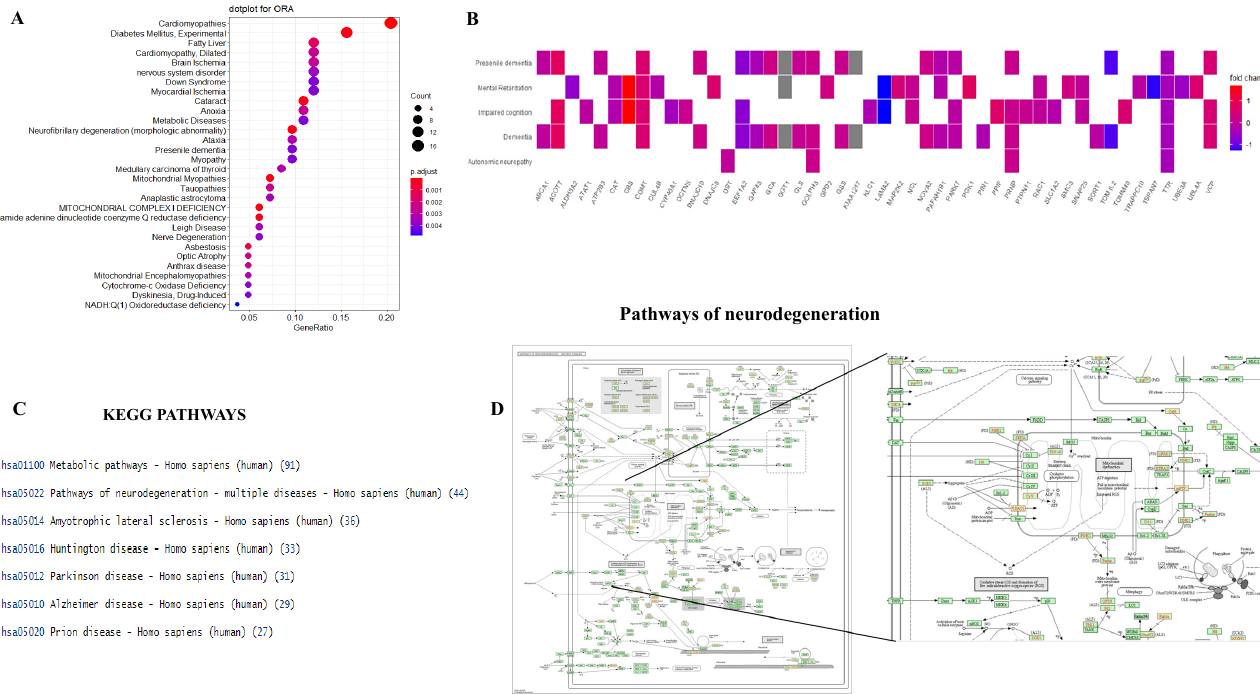
Figure 6. ( A ) Overrepresentation analysis (ORA) plot represents Kyoto Encyclopedia of Genes and Genomes (KEGG) pathway analysis of enriched biological terms associated with proteins. ( B ) The heat plot depicts and identified expression patterns. The relationships between proteins and disorders are displayed as a heatmap. ( C ) KEGG mapper pathway analysis of 426 protein targets identified major pathways in which these proteins are involved. ( D )The diagram shows that the neurodegeneration pathway is one of the pathways in which the 426 protein targets are